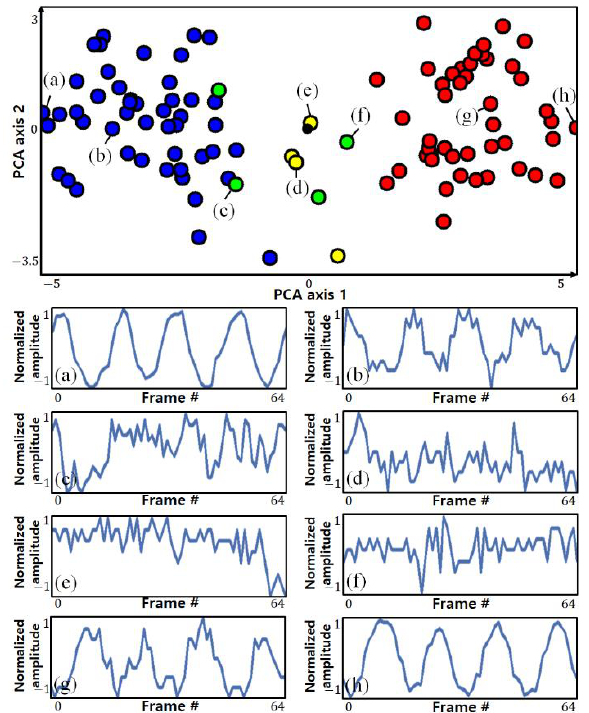
Figure 4. Visualization of the actual ROI pixels and clustering results of PCA ( top ) and the variance in some selected pixels ( bottom ): ( a – h ) arbitrary points on a two-dimensional plane and the trajectory of the points (pixels).